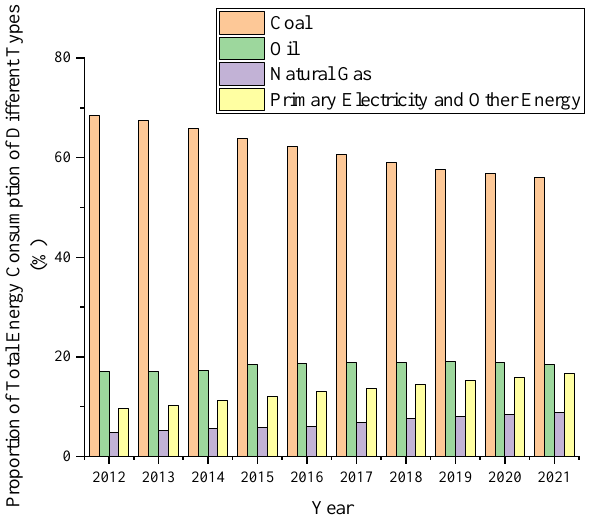
Natural Gas Primary Electricity and Other Energy